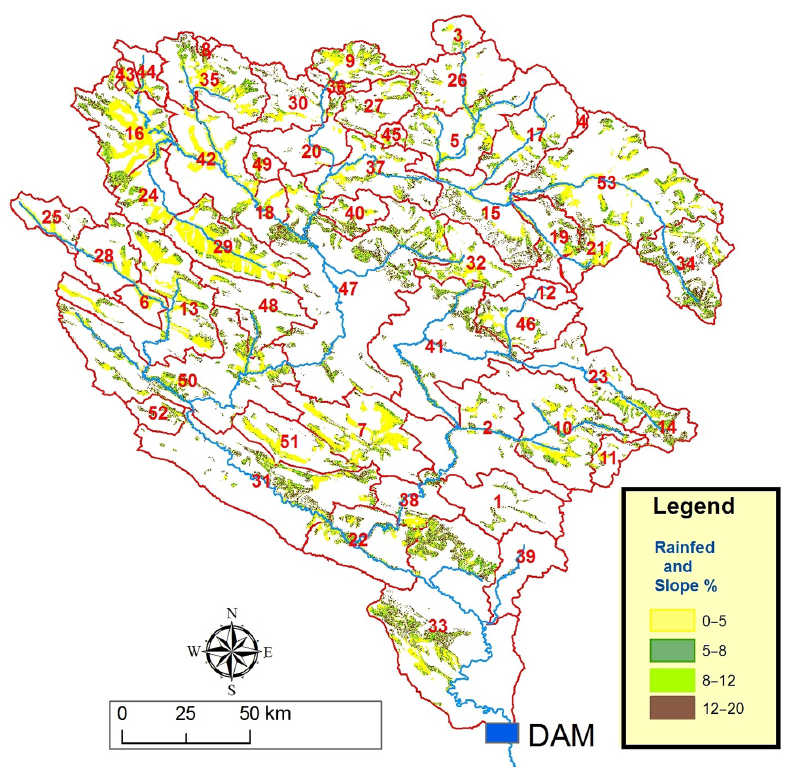
Figure 1. Gauged sub-basins and rainfed areas suitable for supplemental irrigation in upper Karkheh River basin for four different slope